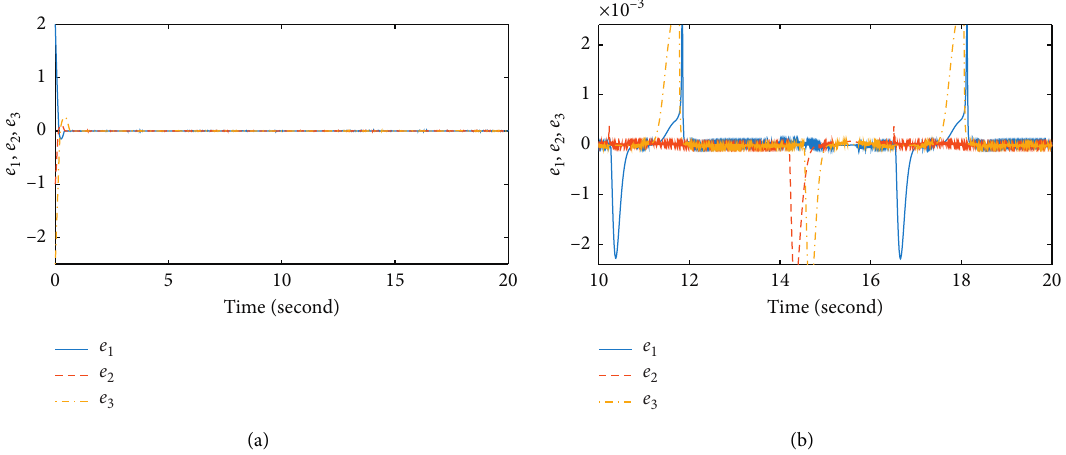
Figure 1: Case 1: the trajectories of tracking error e